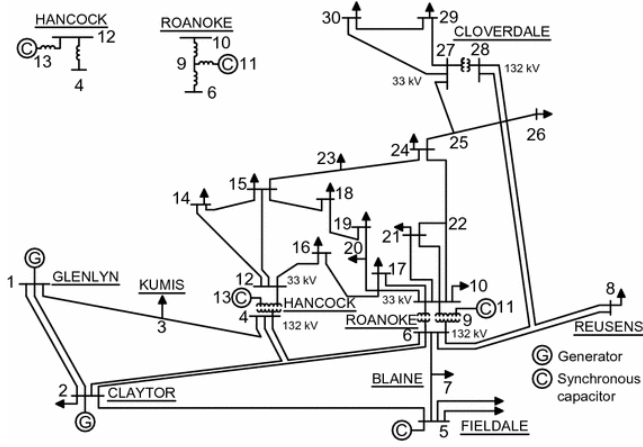
Figure 1. Single line diagram of the IEEE-30 bus test system [43].